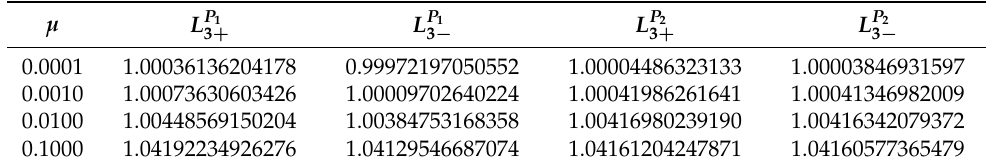
Table 3. Equilibrium solution of R2+2BP near L 3 .